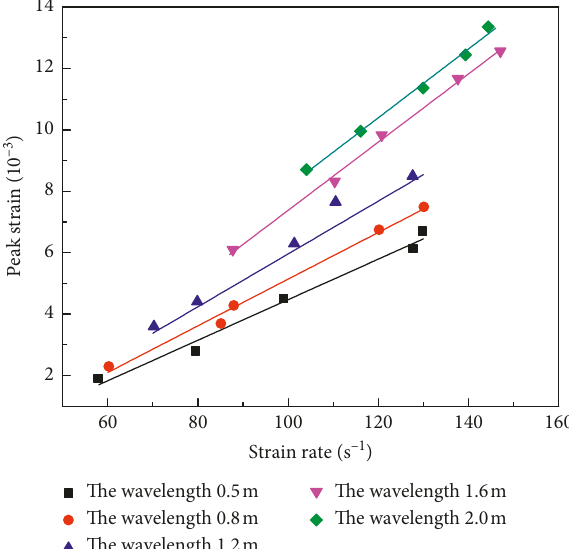
Figure 2: Relationship between dynamic strength and strain rate.